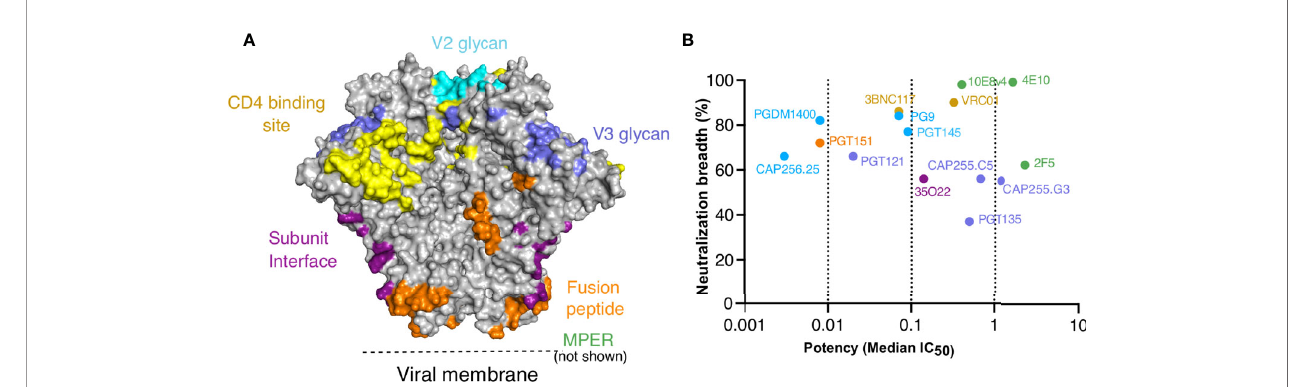
FIGURE 1 | Targets, neutralization breadth and potency of selected HIV broadly neutralizing antibodies. IgG1*01 and IgG3*01 variants of 15 bNAbs that target the six major epitopes of vulnerability were expressed. (A) Major contacts of each of the bNAbs on the BG505 SOSIP.664 trimer (PDB: 6V0R). (B) Neutralization breadth and potency of IgG1 bNAb variants represented by median IC 50 ( m g/ml) against a 200 multiclade virus panel as obtained